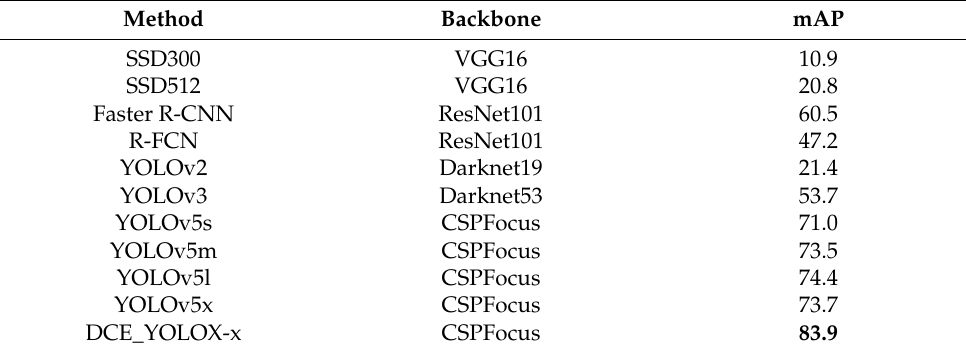
Figure 7. Thefirst32featurevisualizations: ( a )isbeforetheimprovement, and( b )isaftertheimprovement. To further evaluate the performance of the DCE_YOLOX algorithm, using the DOTA dataset with the same training and testing samples, this paper compares Faster RCNN [43], R-FCN [44], SSD [45], YOLOv2, YOLOv3, and YOLOv5 series, and the comparison results are shown in Table 4; the best results are highlighted in bold. Table 4. Detection results of different